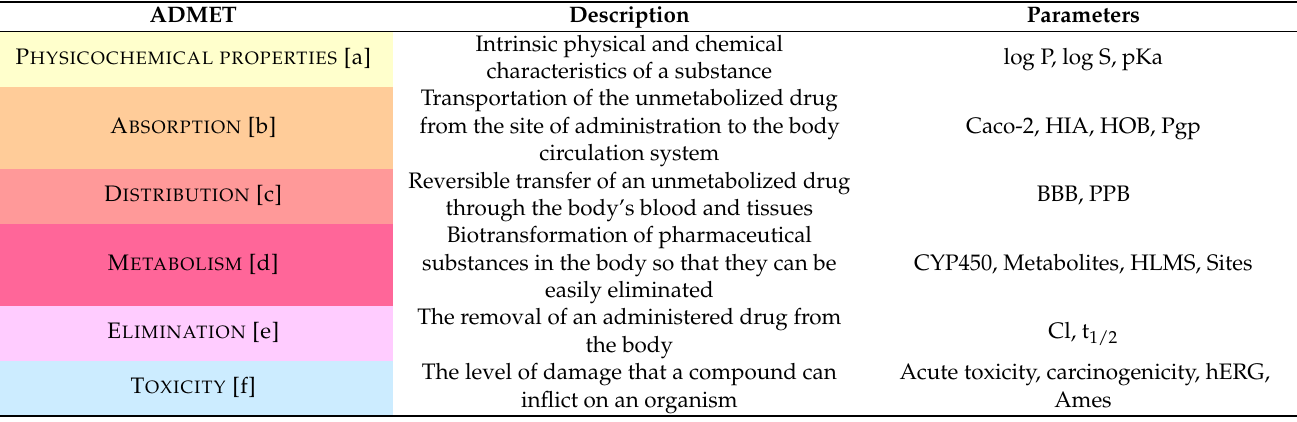
Table 1. Key parameters that describe the pharmacokinetic behavior of a